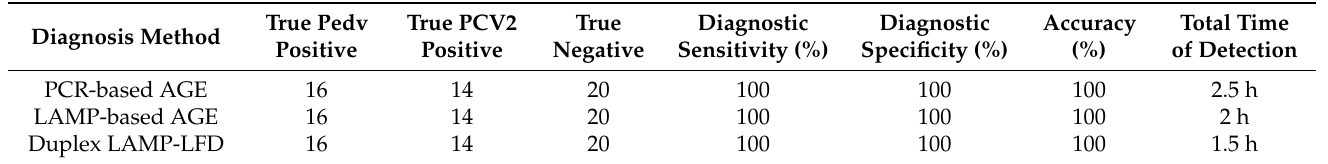
Table 3. Preliminary validation in terms of diagnostic specificity, diagnostic sensitivity, accuracy, coefficient of variation (CV) and process time of PCR-based AGE, LAMP-based AGE and duplex LAMP-LFD for detection of PEDV and PCV2 using 50 swine clinical samples.